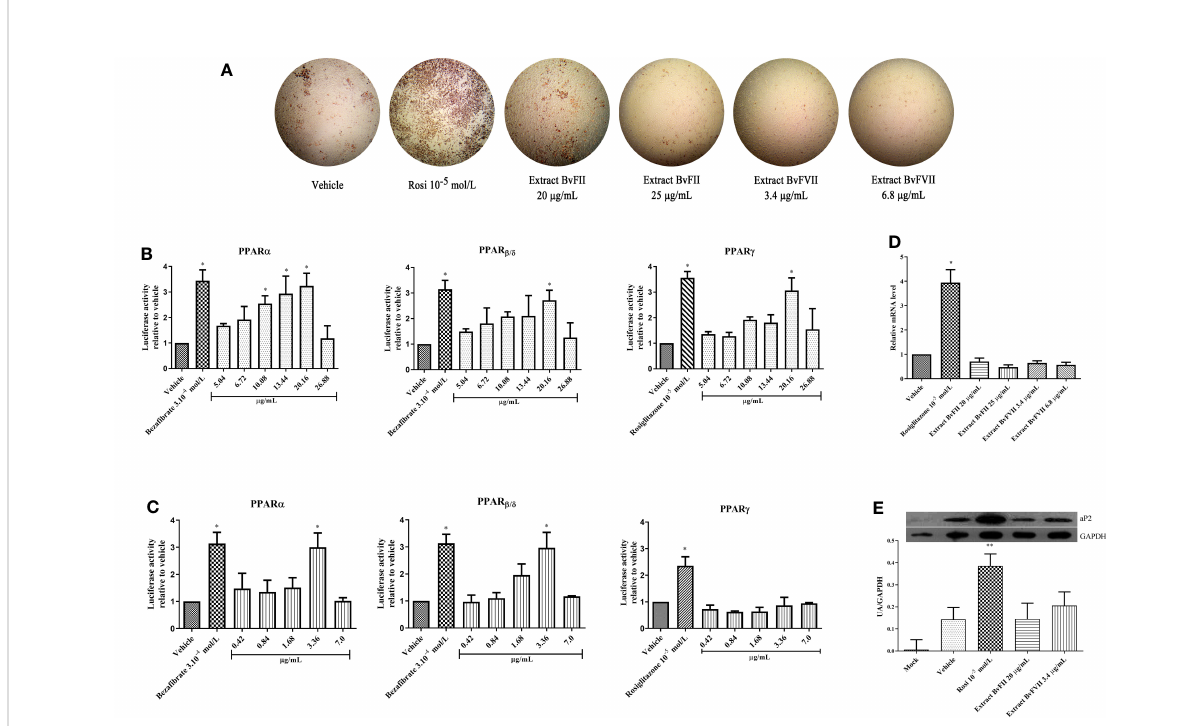
FIGURE 3 Extracts BvFII and BvFVII do not promote adipogenesis in 3T3-L1. Cells were induced to differentiate with insulin and exposed to vehicle (DMSO), Rosi 10 -5 mol.L -1 , Extract BvFII 20 or 25 µg.mL -1 and Extract BvFVII 3.4 or 7.8 µg.mL -1 . (A) After 14 days, the cells were fi xed, stained with oil red O, and photo documented. (B, C) Human mesangial cells were co-transfected with the expression vectors for PPAR a or PPAR g , and the plasmid containing the luciferase reporter gene and treated with vehicle (DMSO:MeOH, 1:3), beza fi brate 3.10 -4 mol.L -1 for PPAR a , b and rosiglitazone 10 -5 M for PPAR g (positive controls) or increasing concentrations of extracts of fungi BvFII (B) and BvFVII (C) . (D) Real-time quantitative PCR to evaluate the expression of Fabp4 (aP2) after 8 days of differentiation. (E) Western blot to evaluate the expression of FABP4 (aP2) protein after 14 days of differentiation. Data are presented as the mean (SD) of three independent experiments conducted in triplicate and expressed as activation relative to transcript levels in vehicle samples (DMSO). *p ≤ 0.05; **p ≤